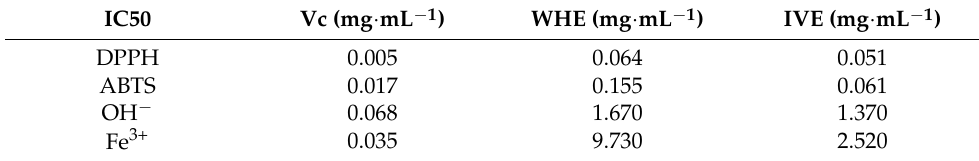
Figure 5. ( A ) DPPH scavenging capacity of the methanol extract of the FJ’s wild H. serrata (WHE) and the methanol extract of the in vitro (IVE), Vitamin C (Vc, 0.010 mg/mL) was used as a positive control. ( B ) ABTS scavenging capacity, Vc (0.25 mg/mL) was used as a positive control. ( C ) OH − scavenging capacity, Vc (2.5 mg/mL) was used as a positive control. ( D ) Ferric reducing ability, Vc (2.5 mg/mL) was used as a positive control. All measurements are expressed as means ± SD of three separate determinations. * p < 0.05 and ** p < 0.01 vs. control. Table 6. The value of